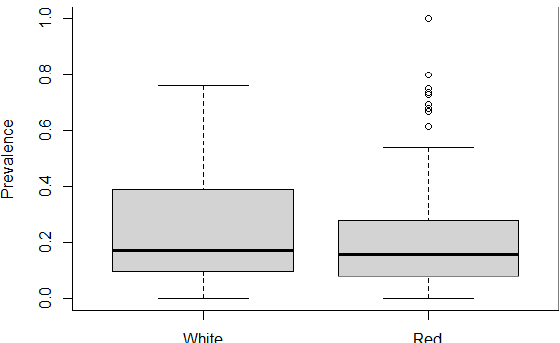
Figure 3. Box plots of weevil infestation prevalence per tree for acorns of both Q. alba and Q. rubra . No significant difference in weevil prevalence was detected for the two tree species (see Results). However, note that the few trees with highest levels of infestation were Q. rubra